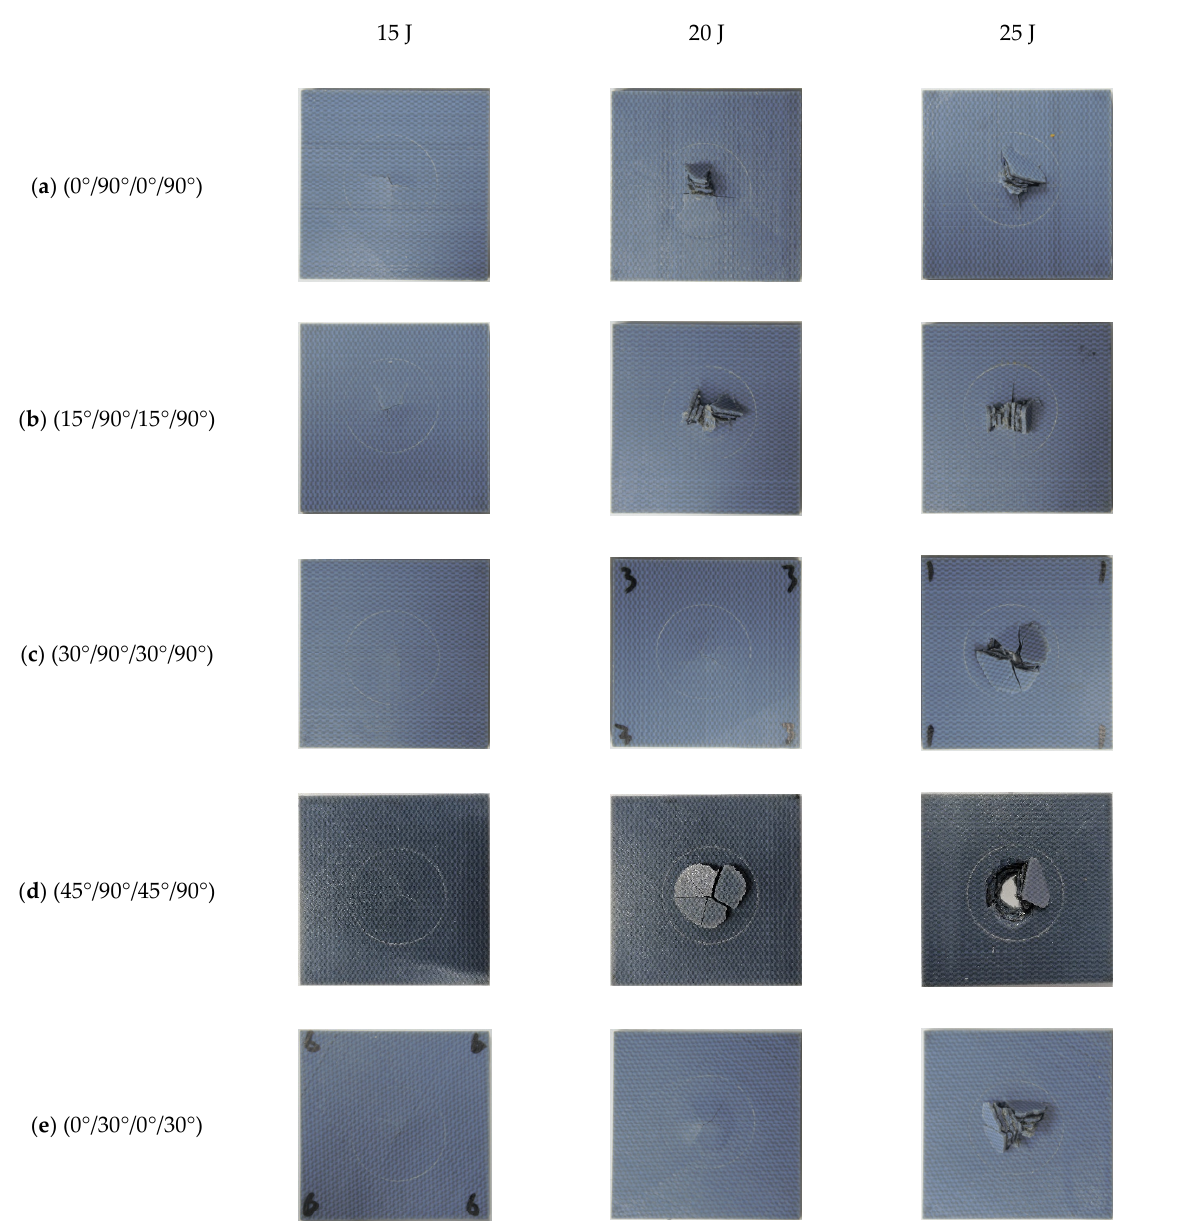
Figure 16. The damage morphologies of Bio-S with different layup configurations. Table 3. EA, velocity change and peak force for Bio-S with the changing angles of middle layer configurations composite plate under different impact energy levels.